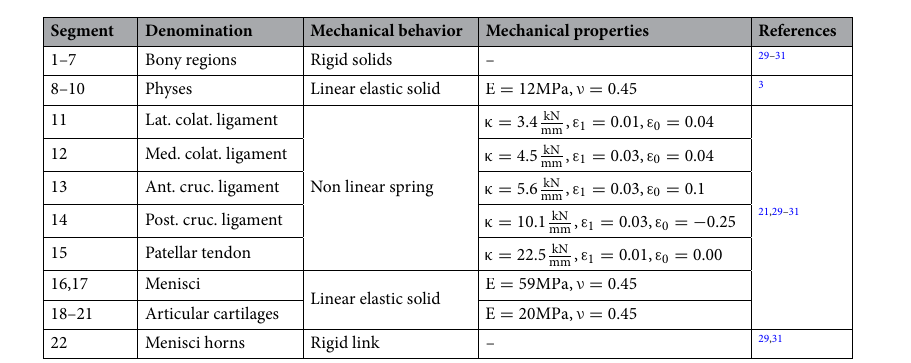
Figure 1. Finite elements model used in the study. Epiphyseal plates have been colored in green. Geometry was obtained from a left 10 years old female patient MRI. (1) tibia diaphysis (2) tibia epiphysis (3) femur epiphysis (4) femur diaphysis (5) fibula epiphysis (6) fibula diaphysis (7) patella (8) tibia physis (9) femur physis (10) fibula physis (11) lat. colat. ligament (12) med. colat. ligament (13) ant. cruc. ligament (14) post. cruc. ligament(15) patellar tendon (16) lat. meniscus (17) medial meniscus (18) lat. tibial cartilage (19) med. tibial cartilage (20) fem. art. cartilage (21) pat. art. cartilage (22) menisci horns.